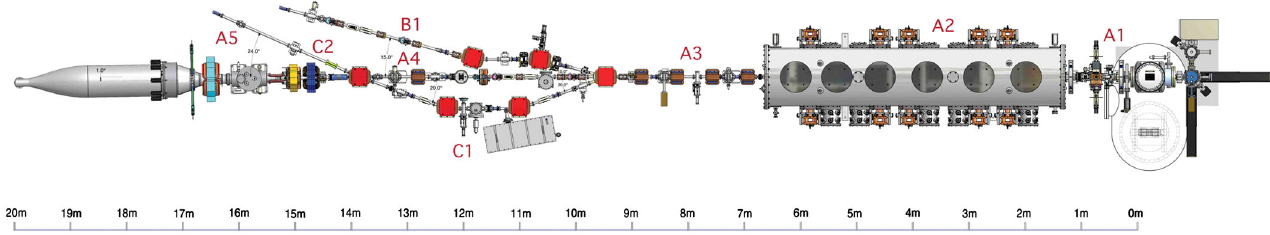
FIG. 1. Top view of the Cornell ERL